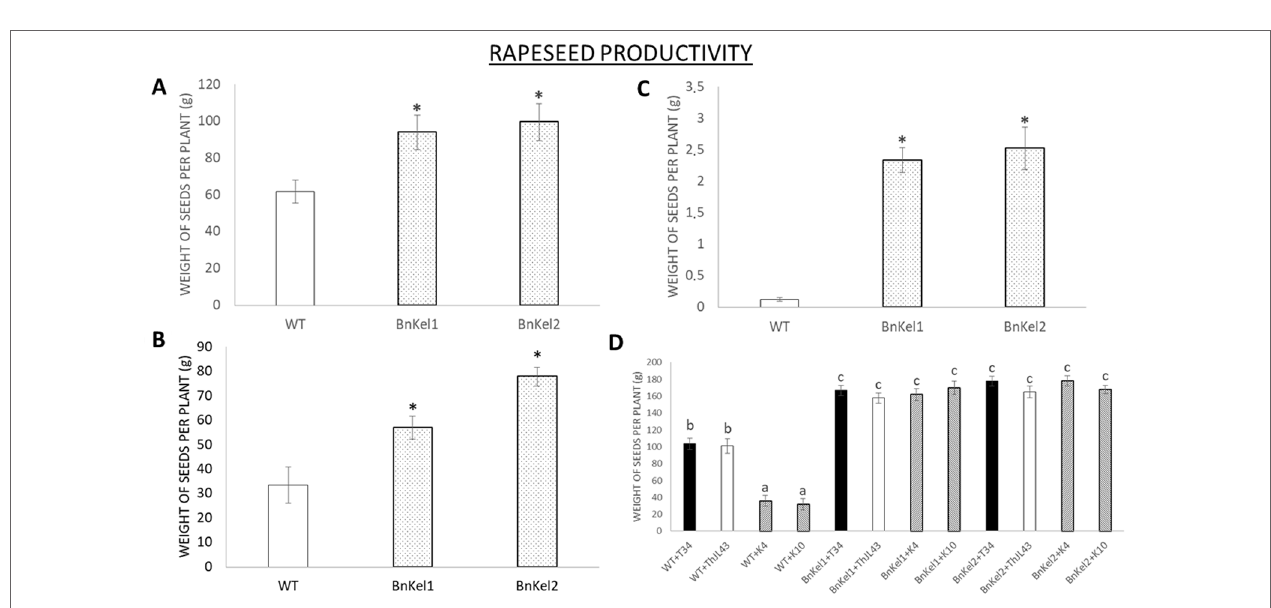
FIgURE 9 | Rapeseed productivity. The weight of the seeds collected from the commercial variety (WT) and the transgenic Thkel1 lines (BnKel1 and BnKel2) per plant without stress (a) , under salt stress (NaCl 200 mM; B ), and under drought stress (C) . The weight of seeds collected after inoculation with the control strain (+T34), the transformation control (+ThJL43), and the transformants with the silenced Thkel1 gene (+K4 and +K10) of T. harzianum (D) . Data are the mean of three biological replicates for each condition with the corresponding standard deviation, and 15 plants per replicate were used. Student’s t-test was performed; asterisks denote significant differences at P ≤ 0.05. One-way analysis of variance (ANOVA) was performed, followed by the Tukey’s test in T. harzianum inoculation. Different letters represent significant differences ( P < 0.05).